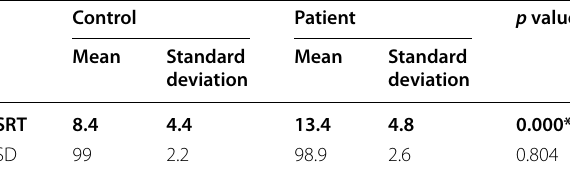
Table 2 Speech audiometry results of the